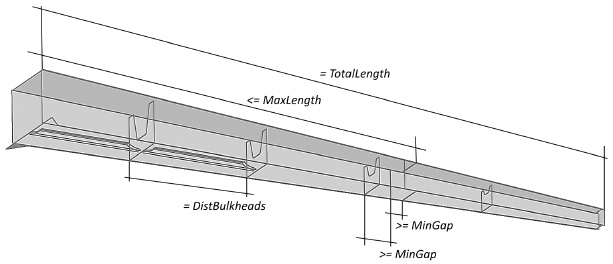
Figure 8. Middle piece of a BTB with indicated variables and constraints for the plate